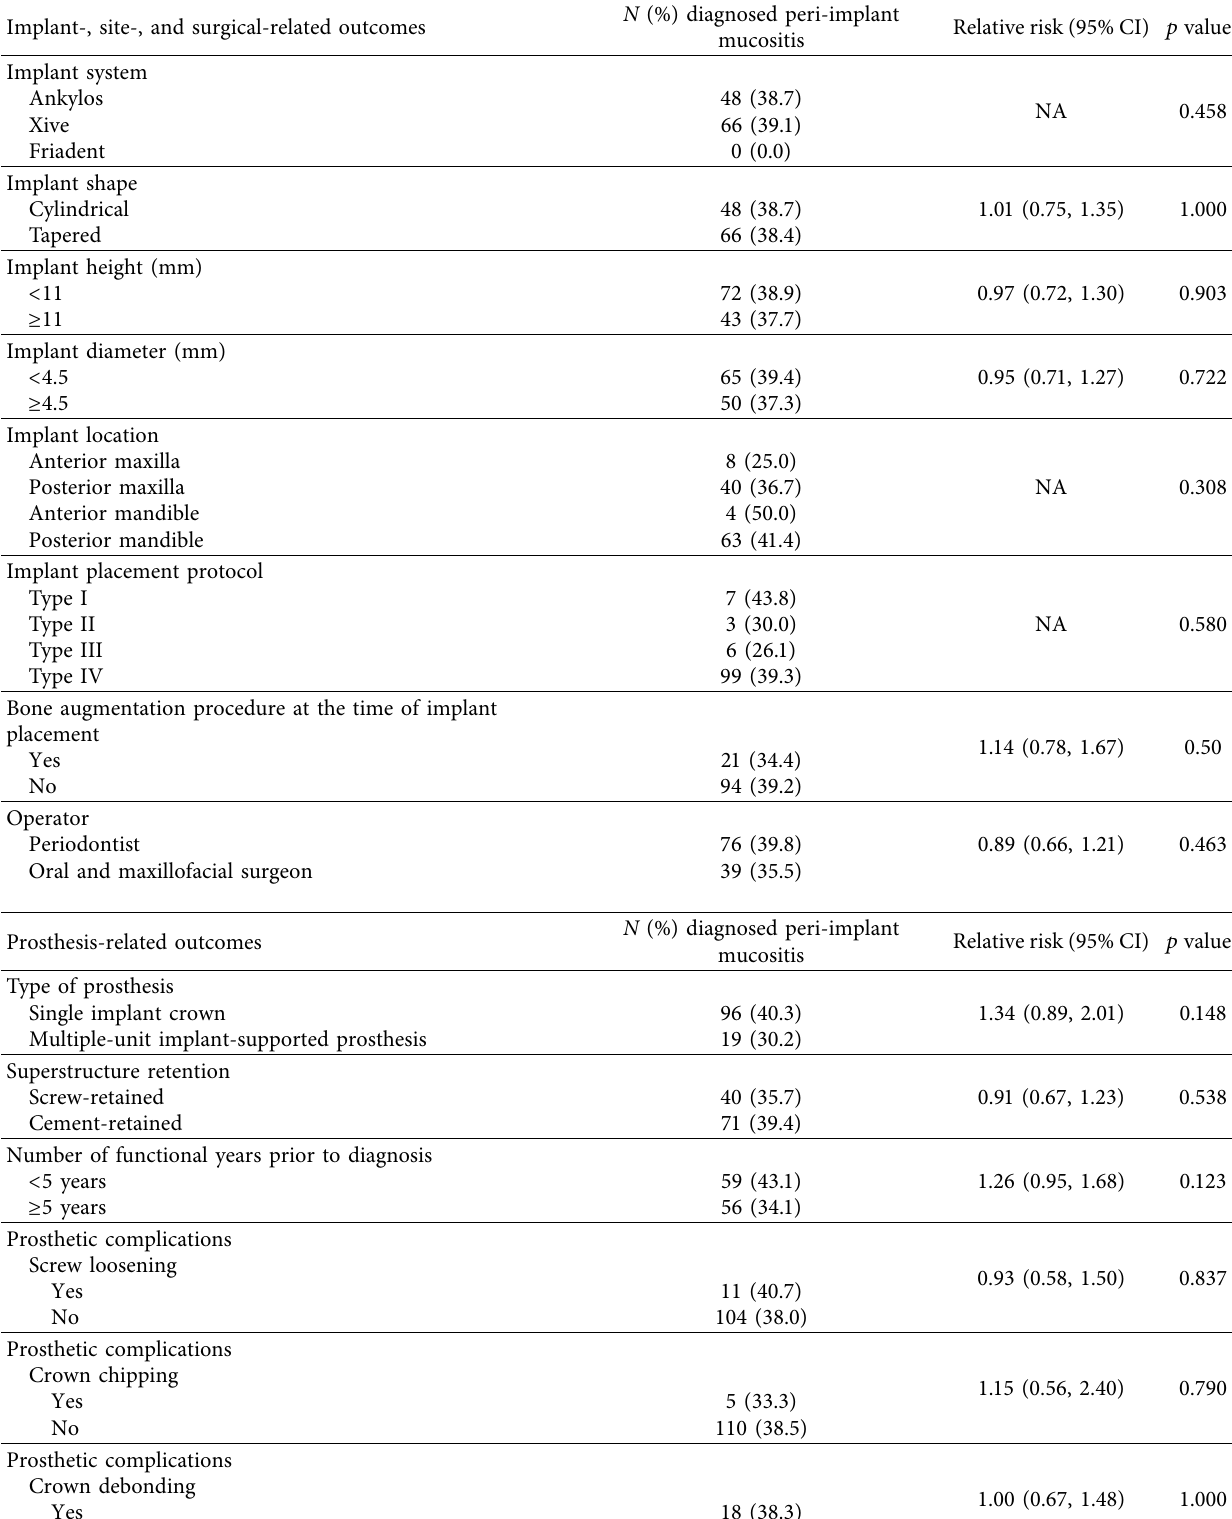
Table 2: Characteristics of implants diagnosed with peri-implant mucositis ( n � 301). Implant-, site-, and surgical-related